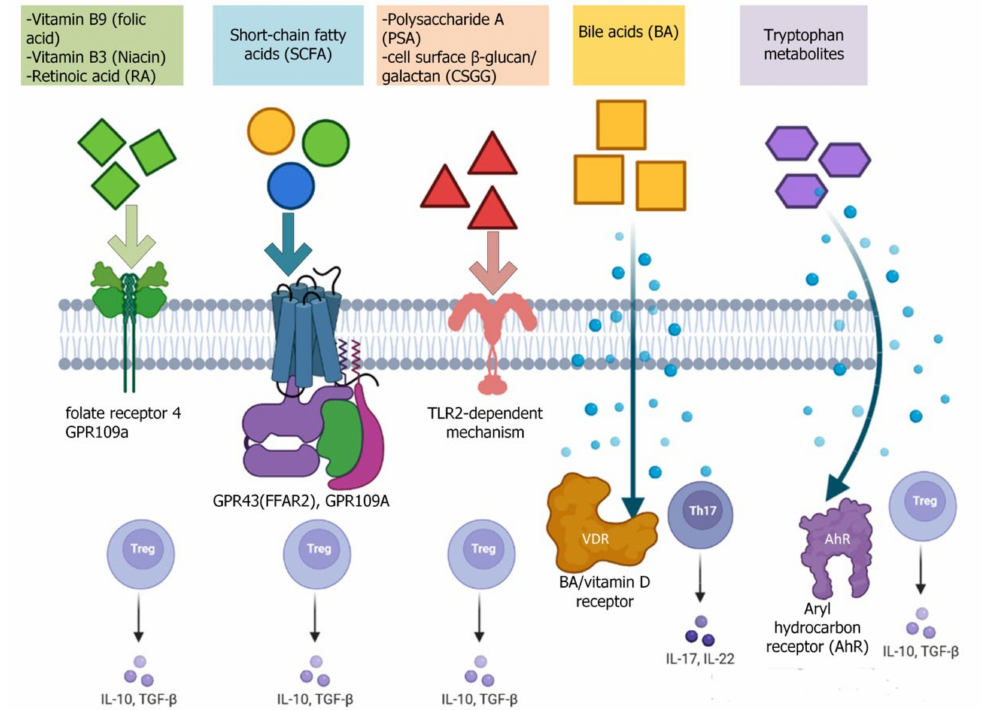
Figure 2. Induction of T-lymphocytes by microbial metabolites. Shown here are the main mechanisms of intestinal CD4+ T cell induction by major microbial